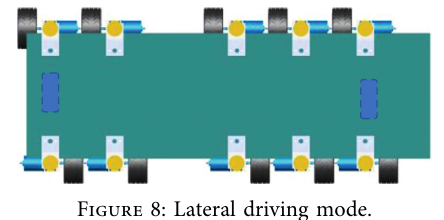
Figure 8: Lateral driving